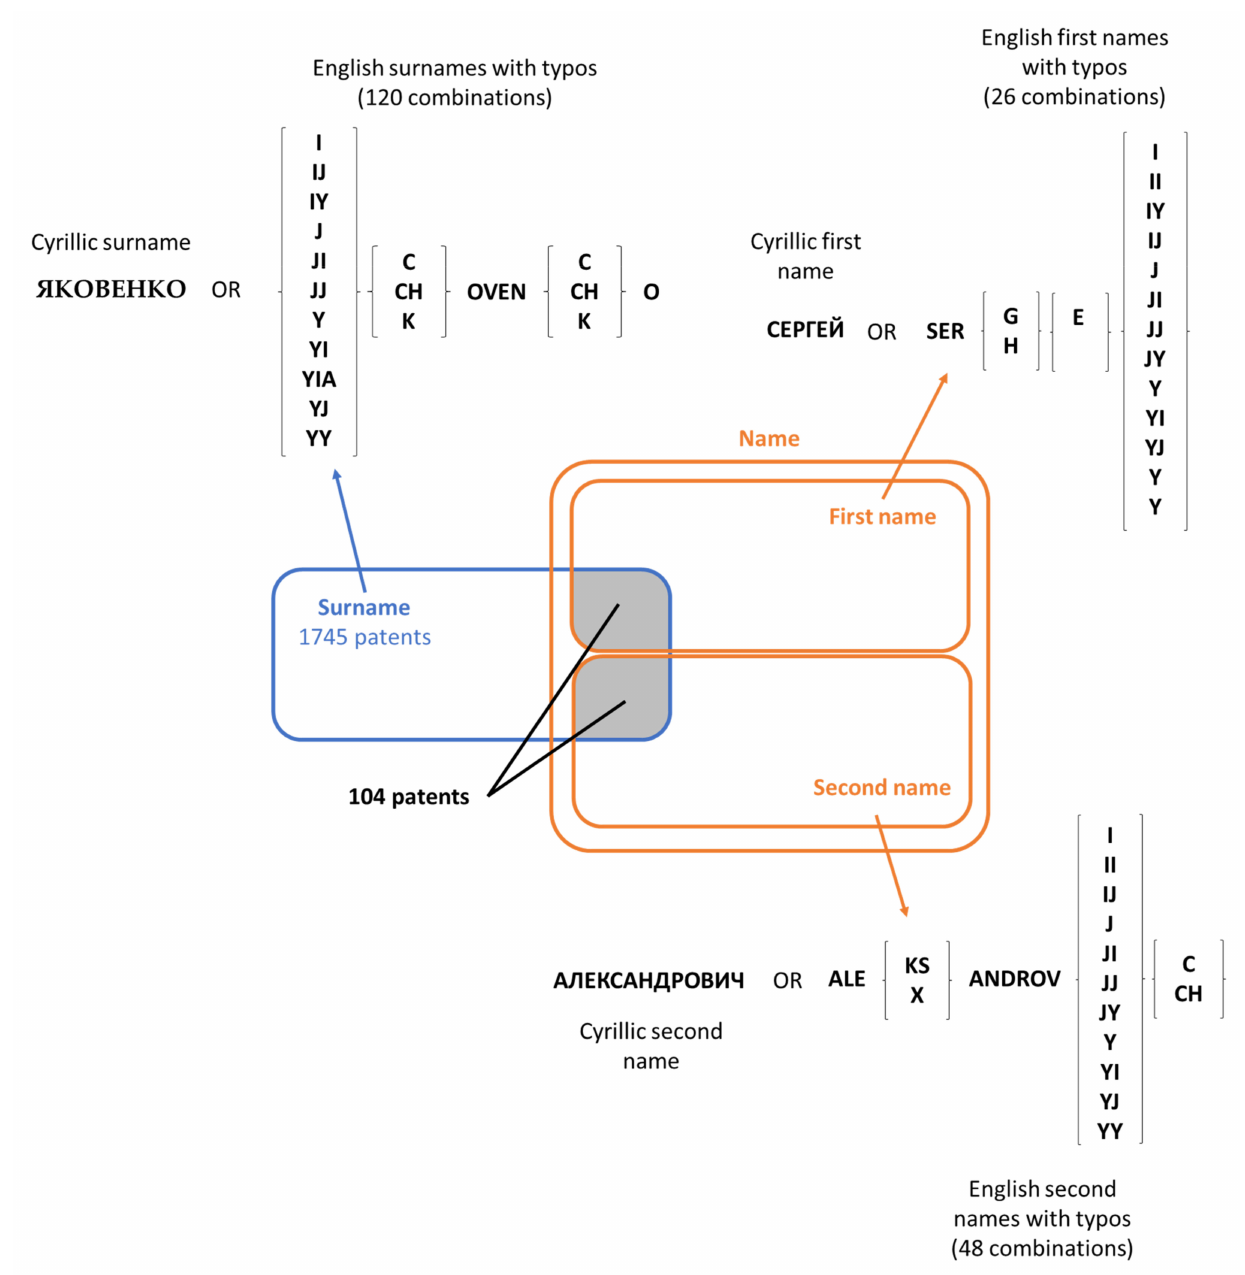
Figure 2. Graphical representation of the possible combinations of misspellings in the search for the name of an